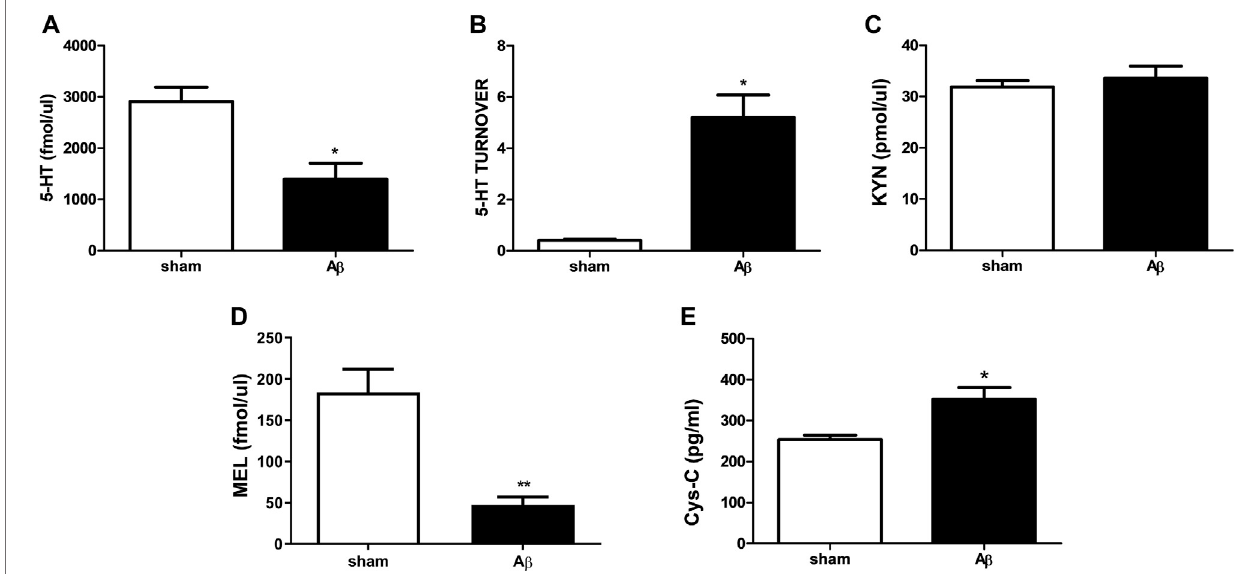
FIGURE 5 | Effects of A β administration on plasma 5-HT, 5-HT turnover, KYN, MEL and Cys-C levels. (A) 5-HT (fmol/ μ l) in sham (n (cid:1) 4) and A β -treated (n (cid:1) 4) animals. Unpaired Student ’ s t-test, * p < 0.05 A β vs sham. (B) 5-HT turnover in sham (n (cid:1) 4) and A β -treated (n (cid:1) 4) animals. Unpaired Student ’ s t-test with Welch ’ s correction, * p < 0.05 A β vs sham. (C) KYN (pmol/ μ l) in sham (n (cid:1) 5) and A β -treated (n (cid:1) 5) animals. Unpaired Student ’ s t-test, p > 0.05 A β vs sham. (D) MEL (fmol/ μ l) in sham (n (cid:1) 5) and A β -treated (n (cid:1) 5) animals. Unpaired Student ’ s t-test, ** p < 0.01 A β vs sham. (E) Cys-C (pg/ml) in sham (n (cid:1) 5) and A β -treated (n (cid:1) 5) animals. Unpaired Student ’ s t-test, * p < 0.05 A β vs sham.